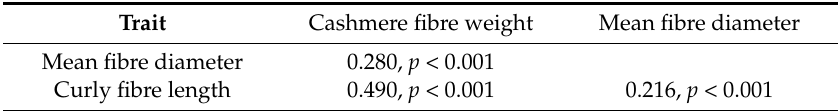
Table 3. Pearson correlation coefficients, r , were calculated to test the strength of the associations between the various traits.